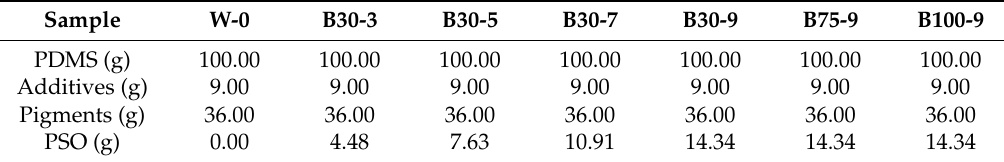
Table 1. Formulation of coating component